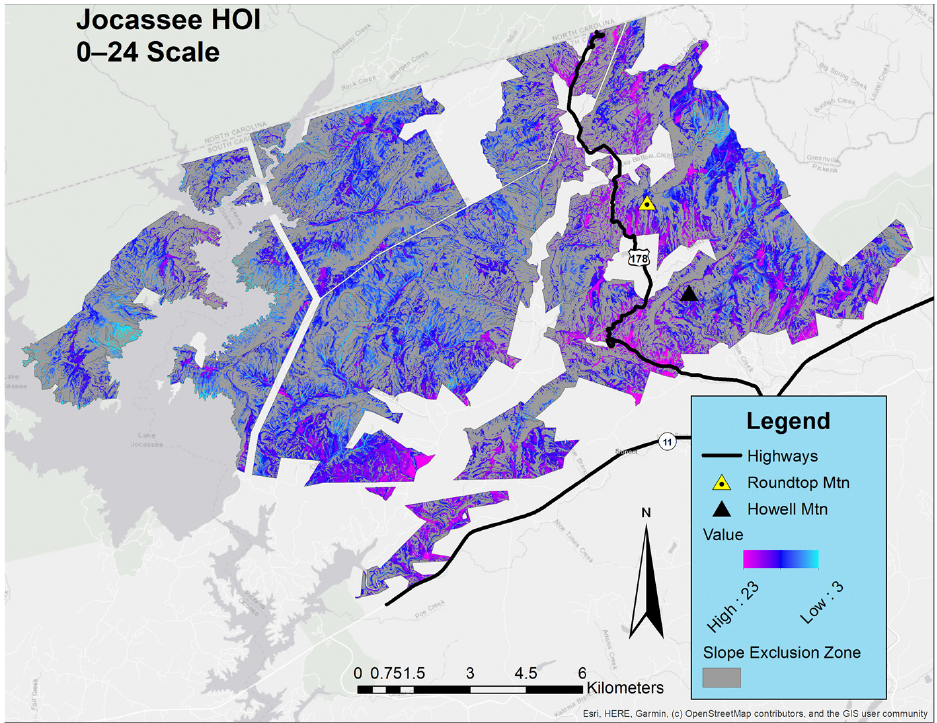
Figure 4. Output of the HOI Model on a 0–24 Scale for Jocassee. Observed scores for the HOI model were 3–23.